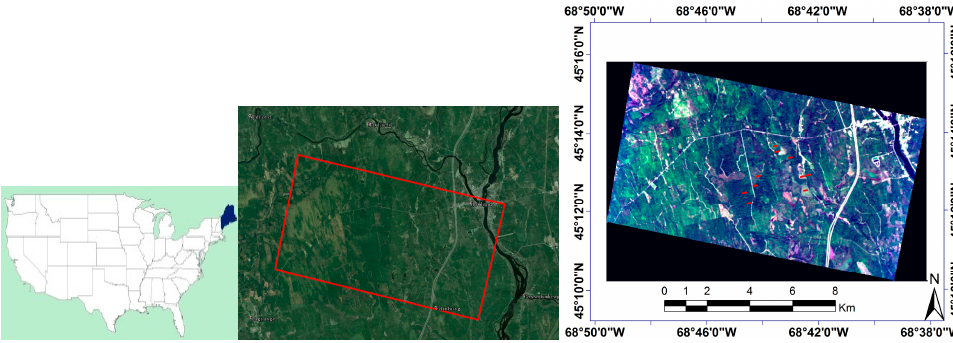
Figure 1. The spatial coverage of CHRIS data used in the Howland study area, and the geographical locations of field samplings (red